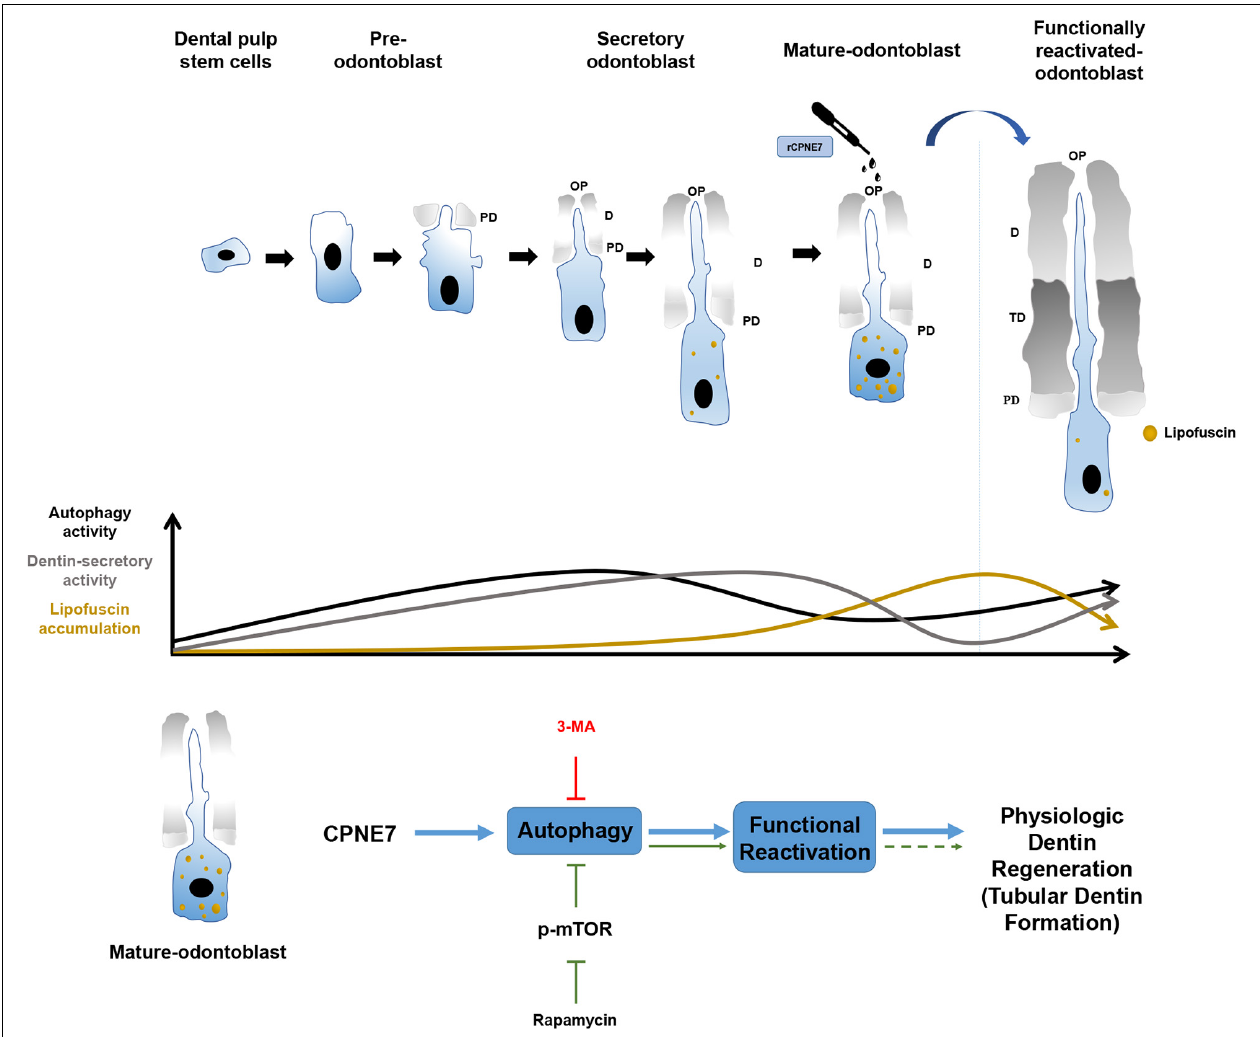
FIGURE 6 | Schematic illustration of the effects of CPNE7 in mature odontoblasts. Dental pulp stem cells have the potential to differentiate into pre-odontoblasts, secretory odontoblasts, and mature odontoblasts. Physiologically, the cellular activities of odontoblasts, such as dentin secretion and process elongation, increase gradually during the early differentiation stage, similar to the increasing autophagy activity. Both the cellular activities of odontoblasts and autophagic activity decrease steadily in mature odontoblasts. Moreover, lipofuscin, an aging pigment, progressively accumulates in mature odontoblasts. Rapamycin-induced autophagy could not properly restore the physiological activity of mature odontoblasts. However, CPNE7-induced autophagy functionally reactivated mature odontoblasts and produced physiological dentin